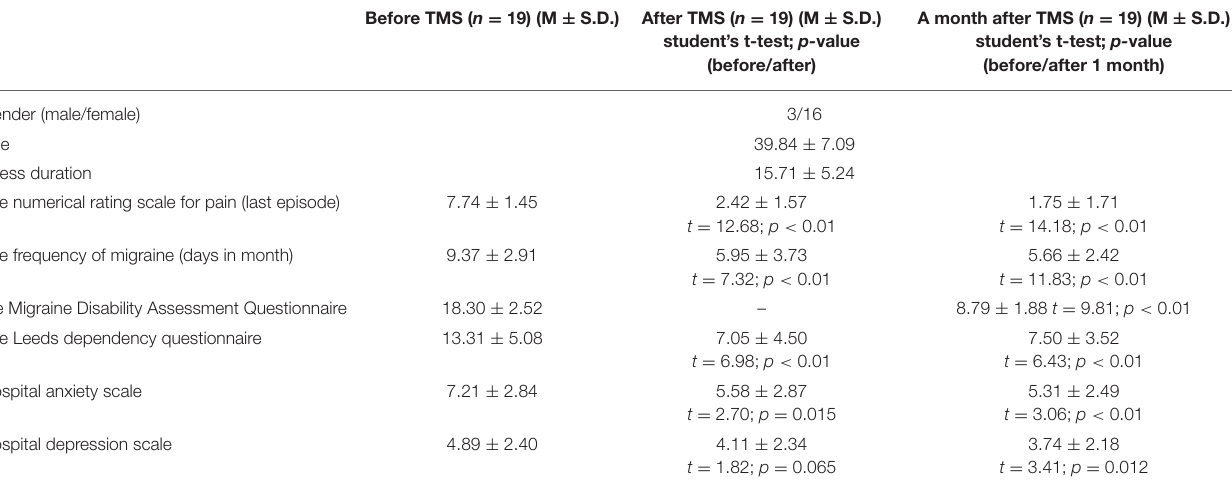
TABLE 1 | Demographical and clinical data of patients before and after a 5-day course of rTMS and 1 month after the treatment (5 of 19 patients undergo more than one TMS therapy